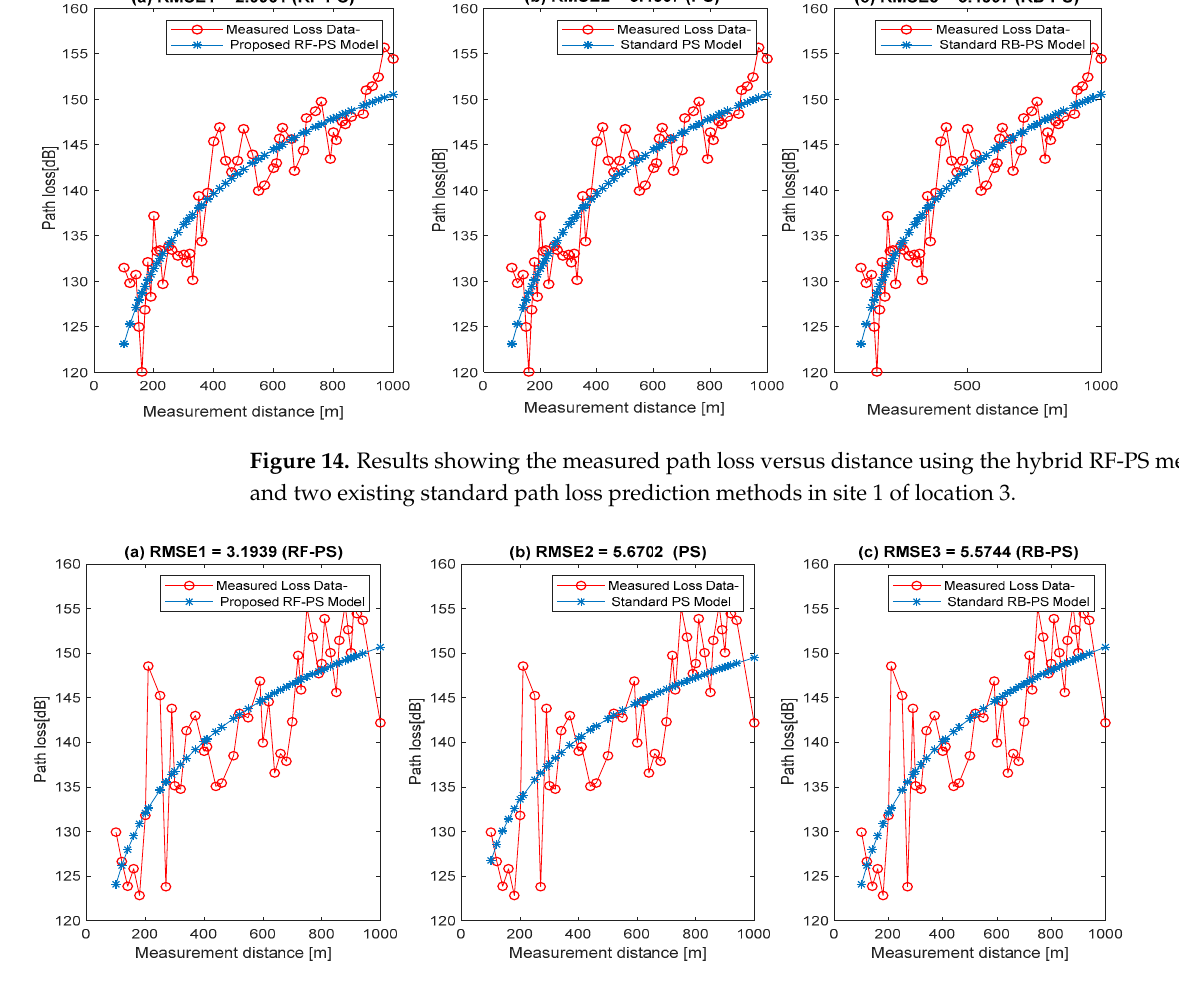
Figure 15. Results showing the measured path loss versus distance using the hybrid RF-PS method and two existing standard path loss prediction methods in site 2 of location 3.